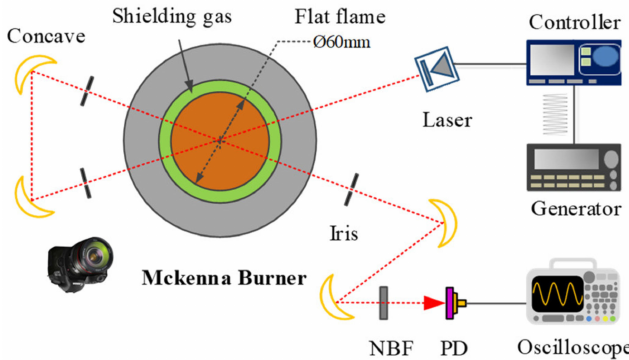
Figure 2. Schematic of the CO measurement on a McKenna burner. NBP: narrow band filter.